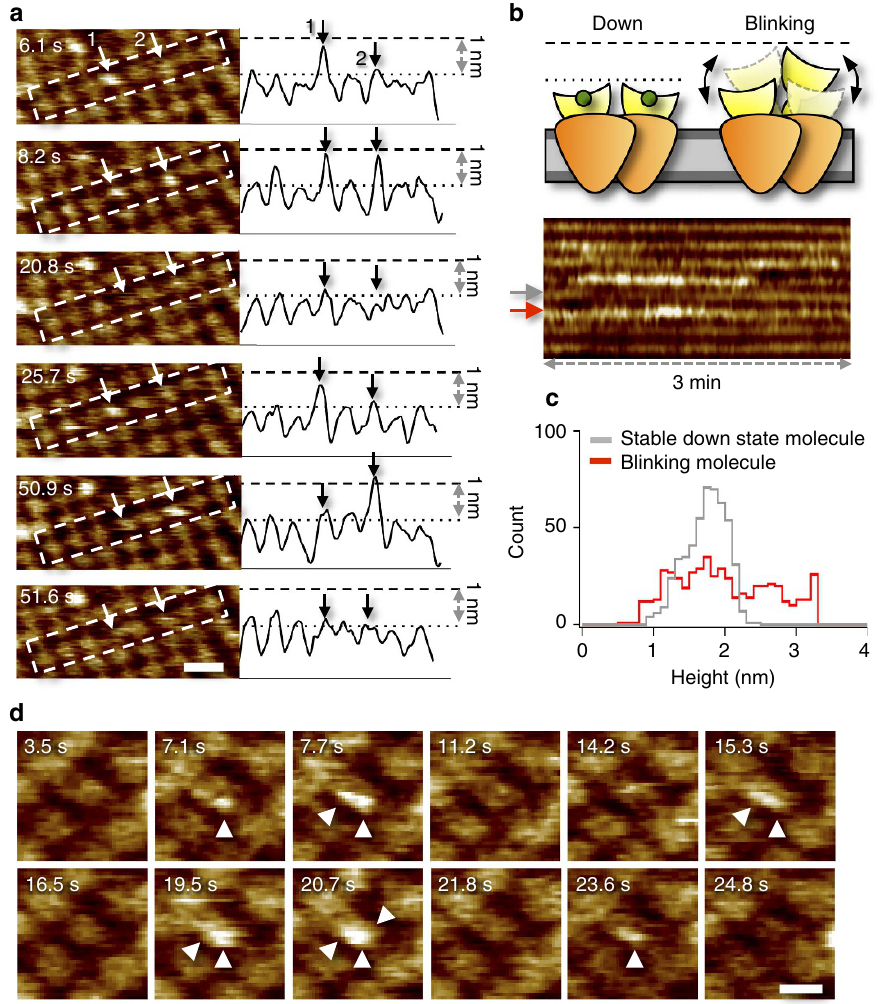
Figure 2 | MloK1 dynamically changes protrusion height during HS-AFM imaging. ( a ) Representative HS-AFM movie frames of the same MloK1- containing membrane. Arrows 1 and 2 highlight two individual molecules continuously blinking between two heights. On the right are the corresponding height profiles along the centre axis of the outlines in each frame on the left. During blinking the CNBDs undergo a height change of B 1nm. Scale bar: 20nm. Full colour scale: 2.5nm. ( b ) Cartoon of the blinking process: unliganded CNBDs alternate between down- and up-states. The kymograph (lower) plots the height evolution over 3min for the eight MloK1 molecules highlighted in a . Colour display is identical. ( c ) Height histograms of the non-blinking (grey) and blinking (red) molecule from the kymograph in b (arrows). While the non-blinking channels show a one-peak distribution, the blinking channels display a broad height histogram. ( d ) High-resolution HS-AFM image frames showing an example of individual blinking subunits (arrows) within an MloK1 tetramer. Scale bar: 10nm. Full colour scale: 2nm. Buffer contains 10nM cAMP for a – c , and 100 m M cAMP for d